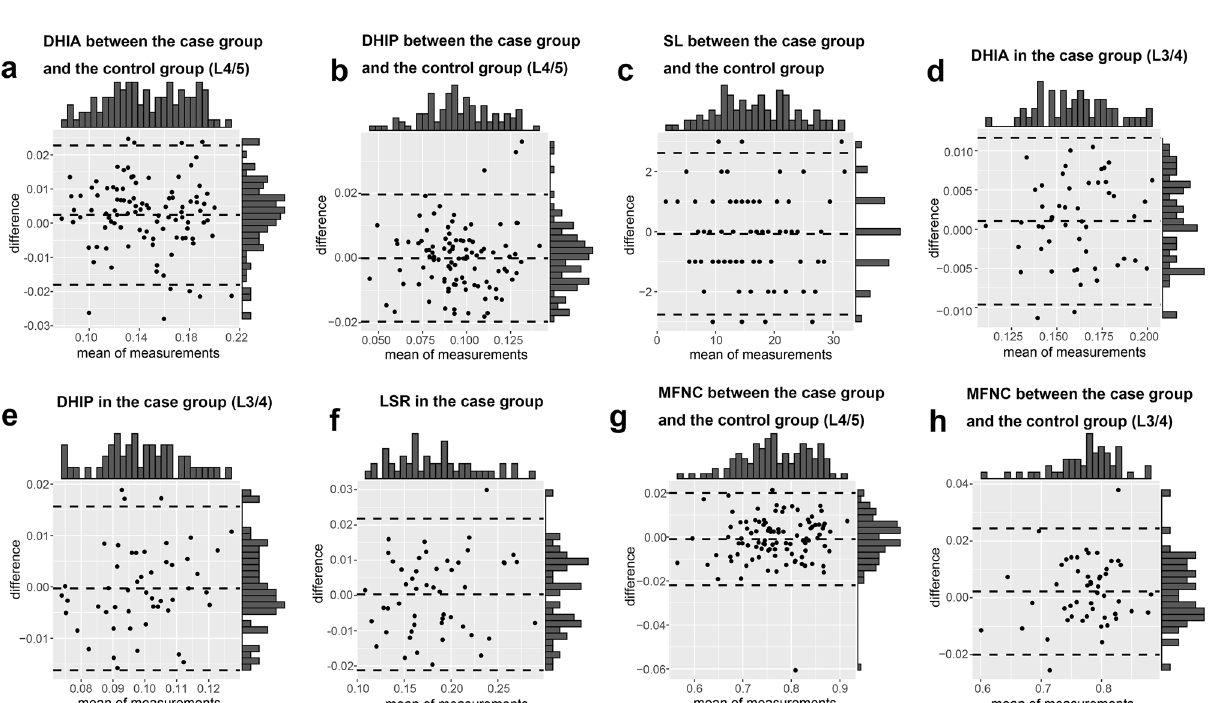
Figure 2. Bland–Altman plots for testing the consistency of data measured by two researchers. ( a ) DHIA between the case group and the control group (L4/5). ( b ) DHIP between the case group and the control group (L4/5). ( c ) SL between the case group and the control group. ( d ) DHIA in the case group (L3/4). ( e ) DHIP in the case group (L3/4). ( f ) LSR in the case group. ( g ) MFNC between the case group and the control group (L4/5). ( h ) MFNC between the case group and the control group